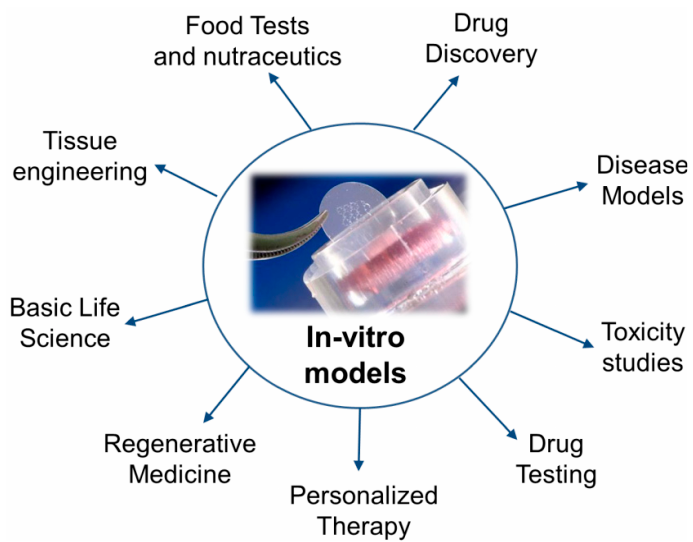
Figure 1. Applications of in vitro